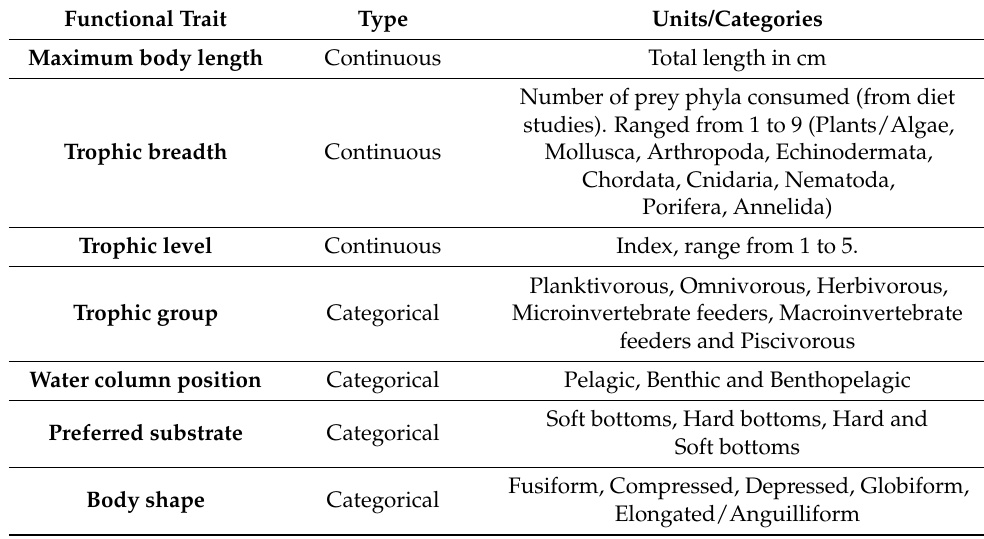
Table 2. Functional traits selected for each species, adapted from [32,53,55]. Functional Trait